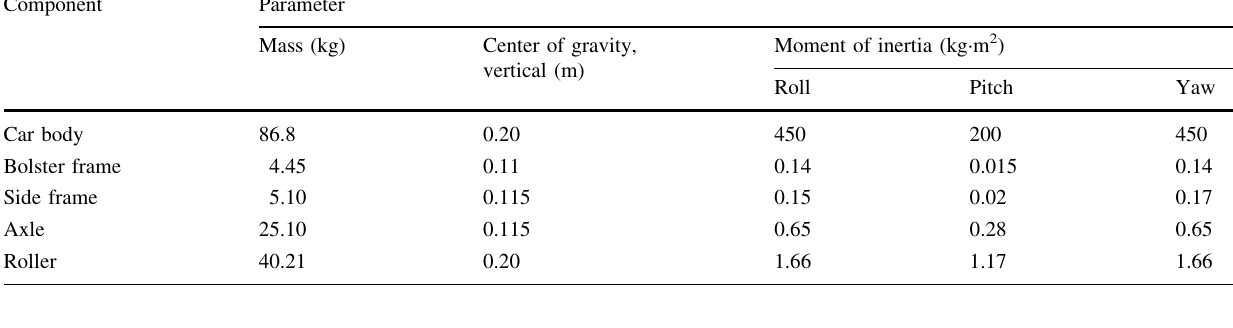
Table 3 Bogie mass and inertia parameters